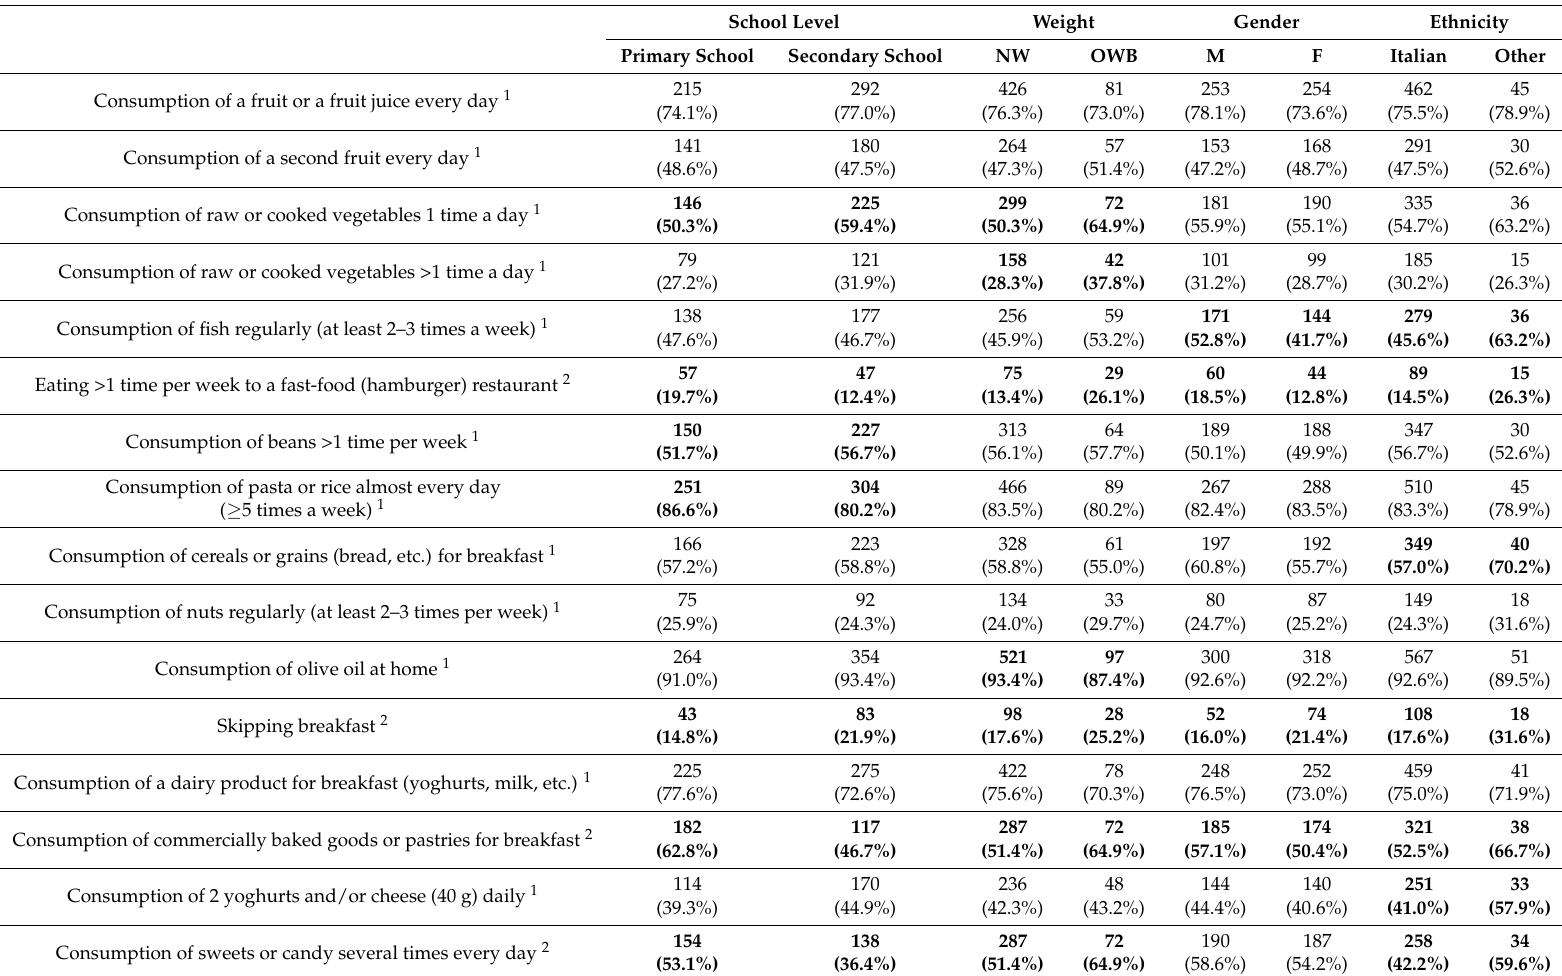
Table 3. Distribution of “yes” answers by school level, weight status, gender, and